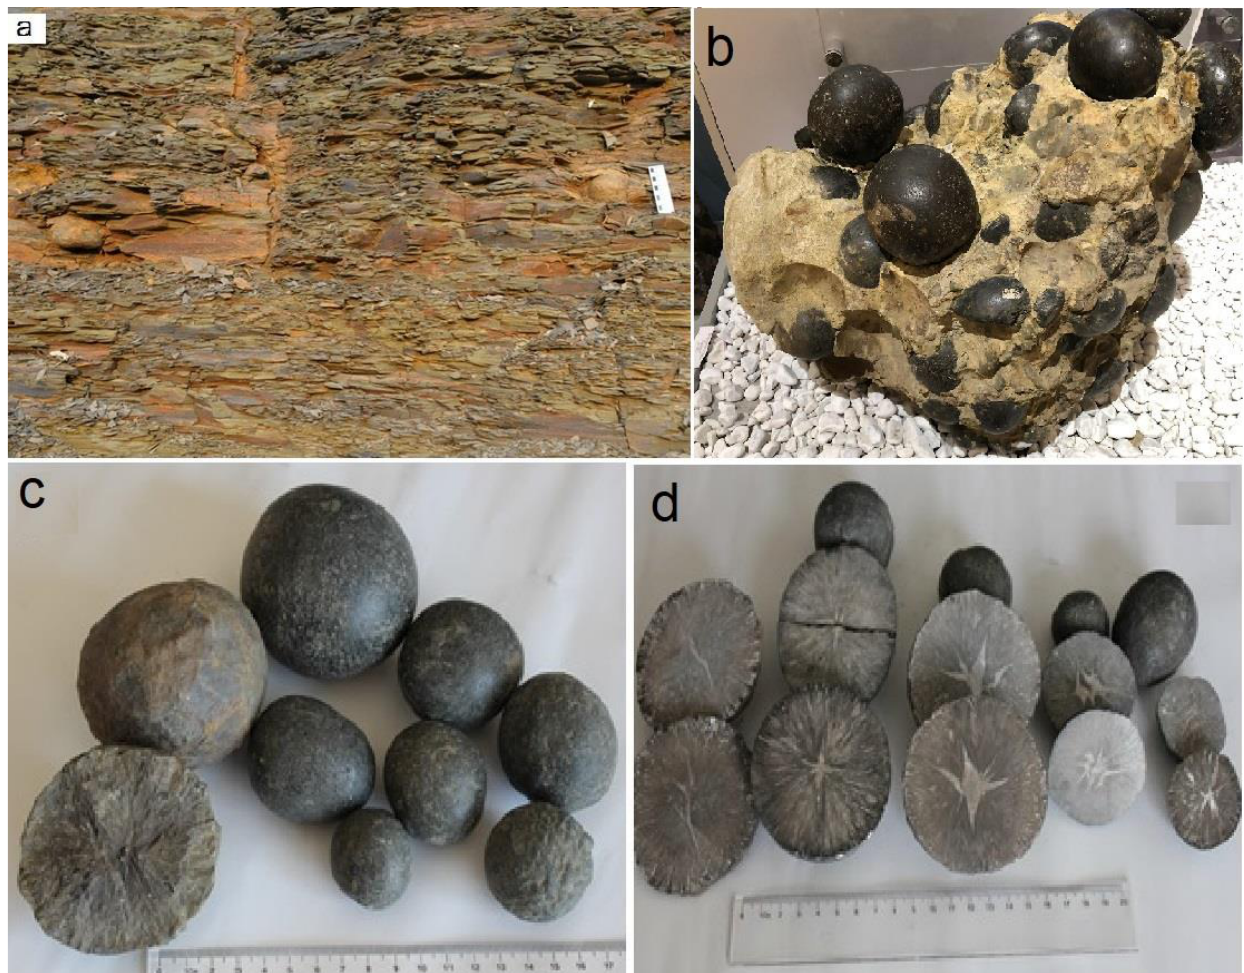
Figure 4. ( a ) Distribution of nodules between layers; ( b – d ) Phosphate nodules in different dimensions and their internal structures.